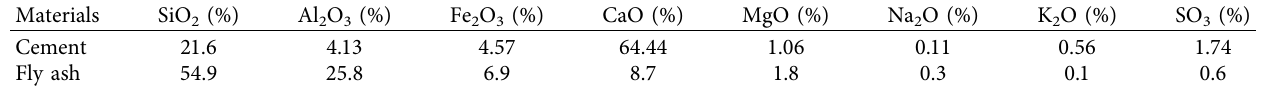
Table 1: Chemical composition of the cementitious materials.